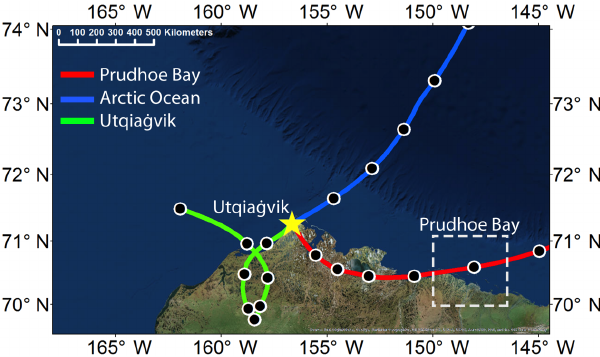
Figure 1. Average 48h HYSPLIT backward air mass trajectories for three major areas of influence: Prudhoe Bay, the ice-free Arctic Ocean, and the town of Utqia˙gvik. Time intervals of 6h are indi- cated by black circles. The Utqia˙gvik, AK, sampling site is indi- cated by the yellow star, and the area of the greatest Prudhoe Bay emissions influence is indicated by the white dashed square as de- fined by Kolesar et al. (2017). The map background was provided by ArcGIS 10.3.1 with the World Imagery base map (sources: Esri, DigitalGlobe, Earthstar Geographics, CNES/Airbus DS, GeoEye, USDA FSA, USGS, Getmapping, AeroGRID, IGN, IGP, and the GIS user